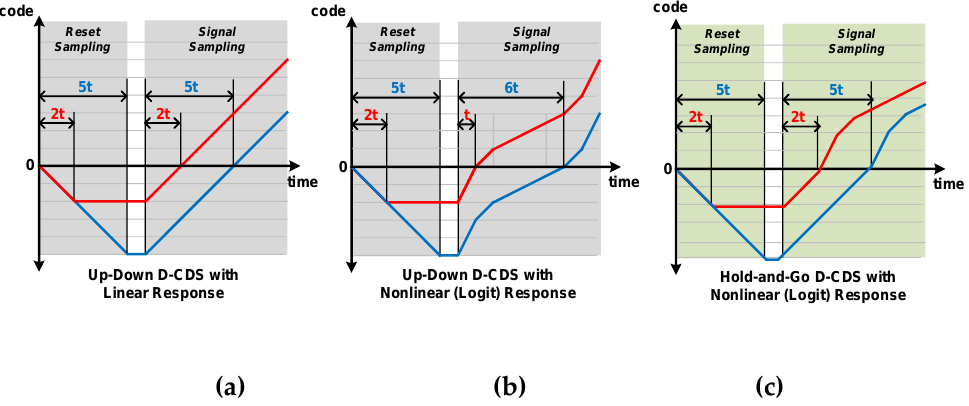
Figure 1. D-CDS output using up-down counter with ( a ) linear response and ( b ) nonlinear response, and ( c ) using hold-and-go counter with nonlinear